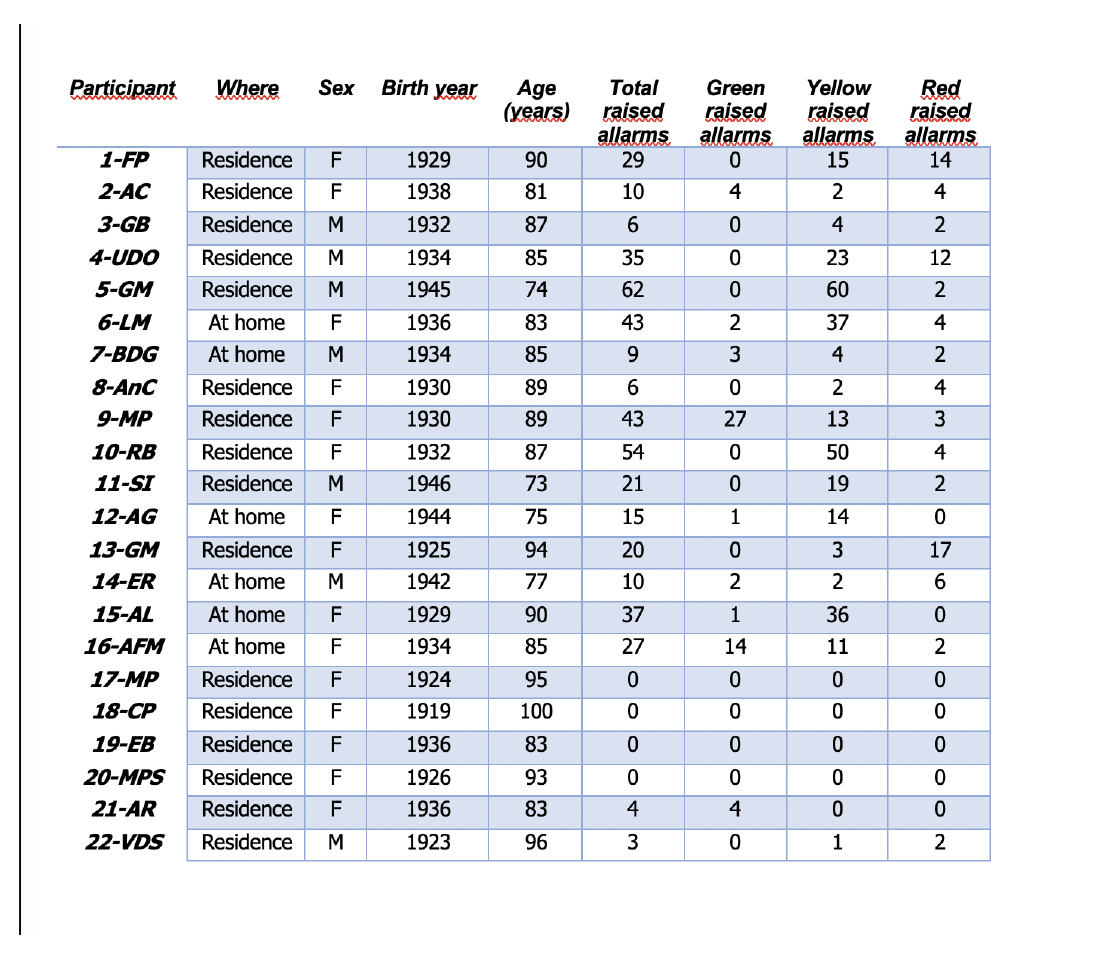
Table 1. List of the participants and raised